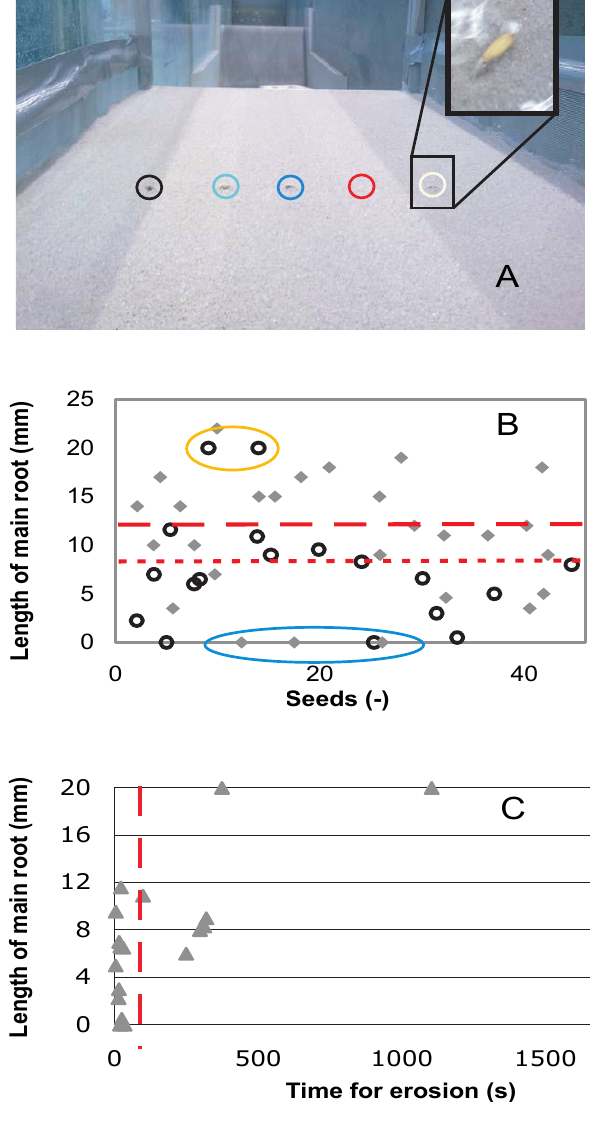
Fig. 7. (A) : experimental setup in flume channel; circles indicate colored seedlings.; (B) : length of main root of eroded (black circles) and not eroded (gray triangles) seedlings; the dashed line indicates the threshold rootlength for Type I (shorter main rot) and Type II (longer main root) erosion (C) : time needed for erosion and length of main root for eroded seedlings; vertical dashed line indicating threshold between instantanious Type I and rather delayed Type II erosion.